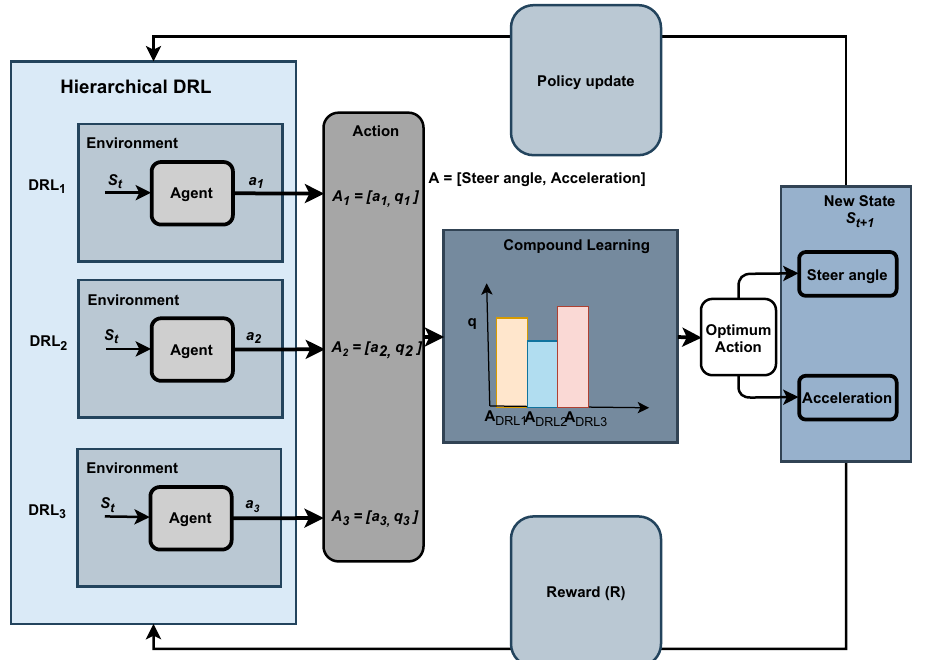
Figure 8. Proposed decision-making model for avoid